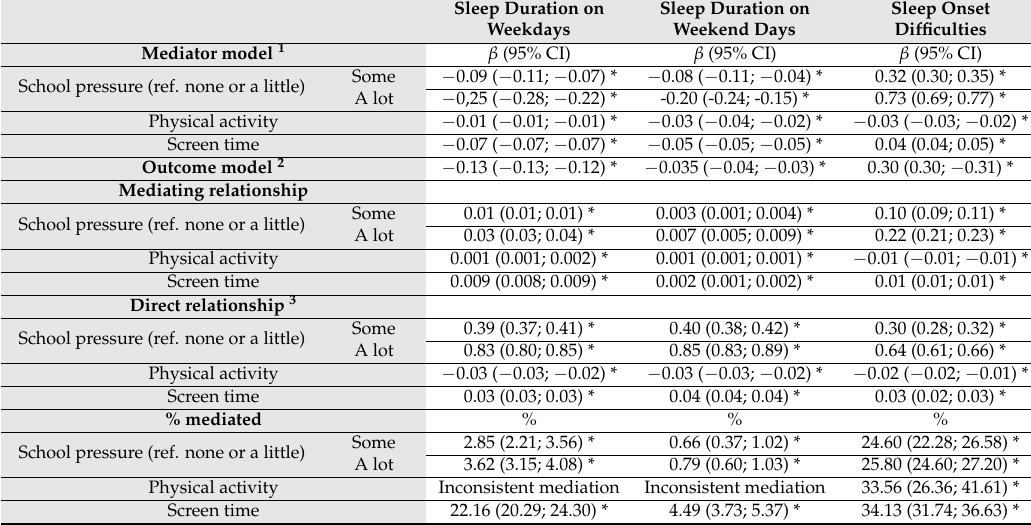
Table 2. Results of the mediation